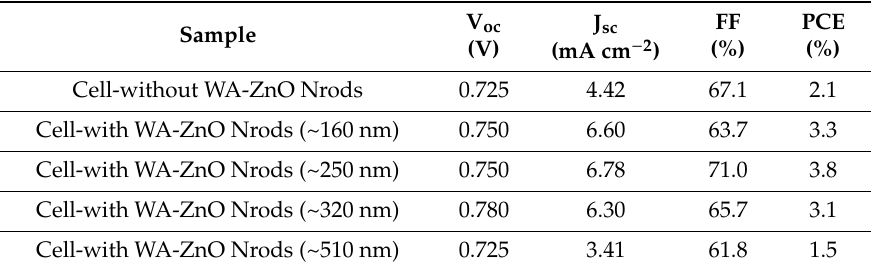
Figure 5. J–V curve characteristics of the device with structure of glass / ITO / ZnO seed layer / WA- ZnONrod / (P3HT:PCBM) / WO 3 / EGaIn with various reaction time of 1 to 4 h. Table 1. Device parameters without- and with VA-ZnO Nrod (varied of length) such as short-circuit current density (J SC ), open-circuit voltage (V OC ), fill factor (FF), and power conversion efficiency (PCE) were compared.